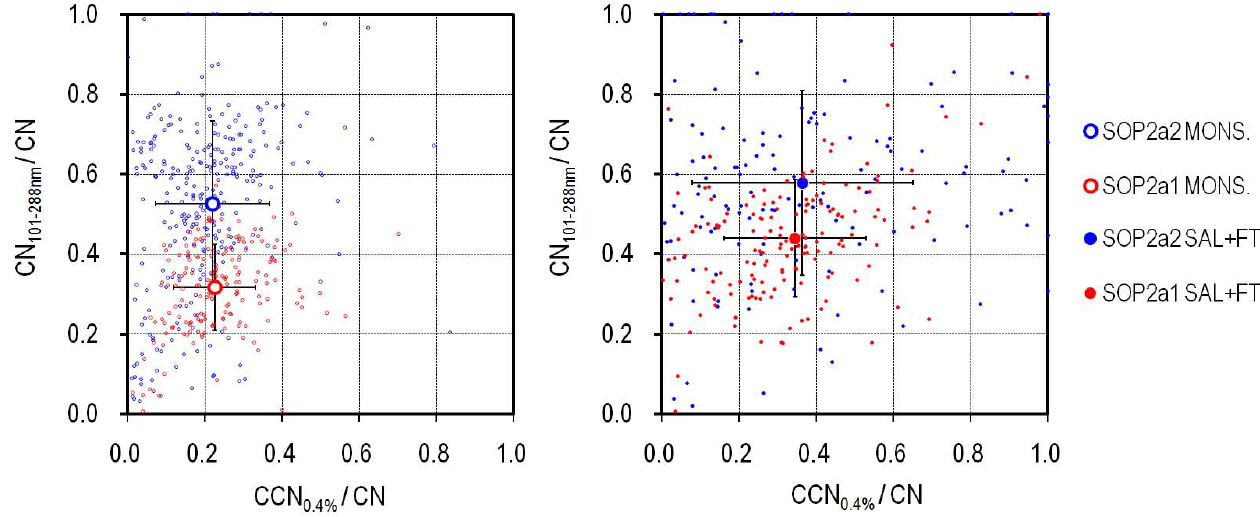
Fig. 7. Relationship between CCN/CN ratio (at 0.4% super saturation) vs. number fraction of particles in CCN relevant sizes (101 < Dp < 288nm) over total CN concentration. Average plots representing the 4 different populations are shown in larger circles and the error bars indicate 1 standard